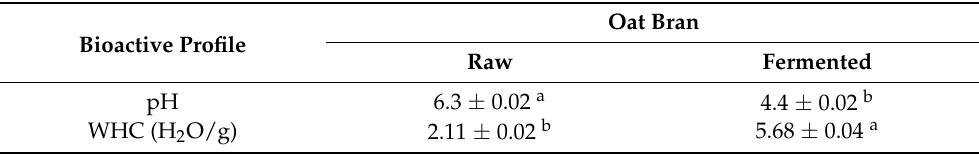
Table 3. Water-Holding Capacity of raw and fermented oat